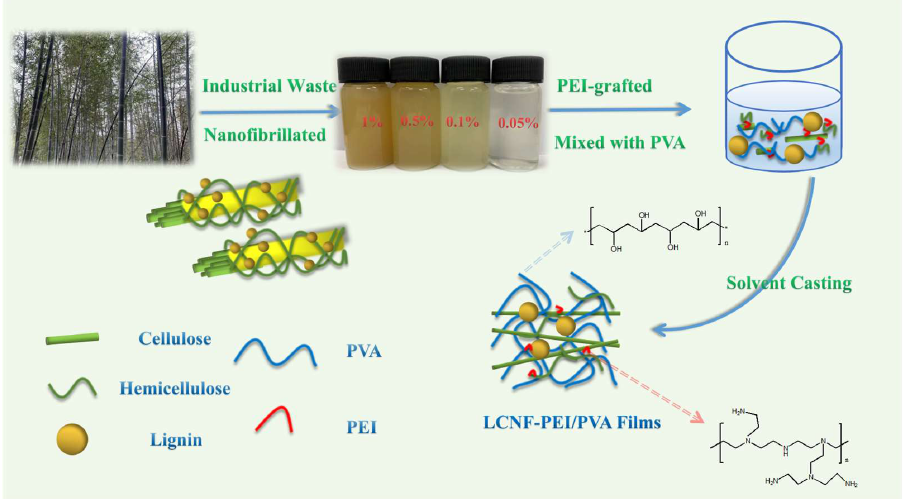
Figure 2. Schematic preparation of LPP nanocomposite